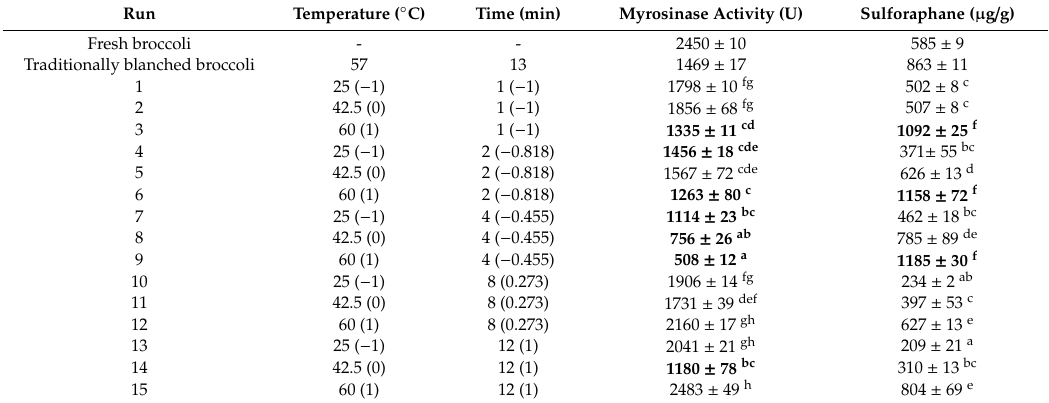
Table1. Experimentaldesignandresponses. Codedlevelsofexperimentalfactorsappearinparentheses.